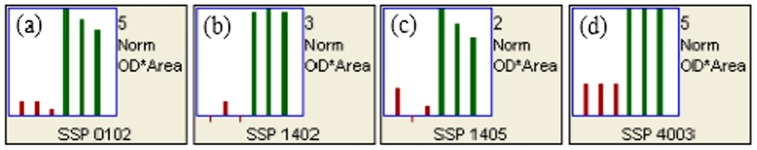
Histogram representing the four upregulated leaf proteins of A. paniculata in the salt-treated plants.The red color refers to the quantity of leaf proteins in control samples (downregulated) and the green color shows the quantity of leaf proteins in salt-treated samples (upregulated). Spot No. 0102 (a), spot No. 1402 (b), spot No. 1405 (c) and spot No. 4003 (d).